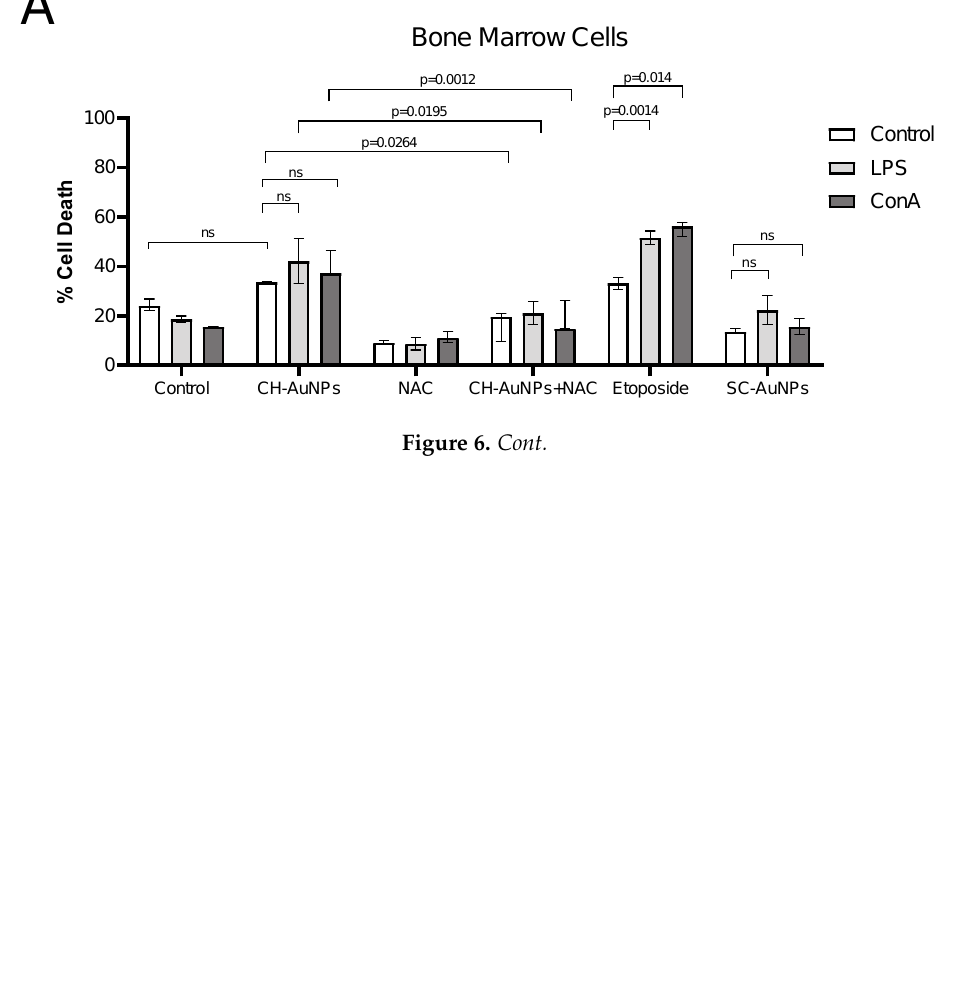
Figure 6. Cell-death analysis of CH-AuNPs, SC-AuNPs, and etoposide in BMCs, splenic mononuclear cells, and PBMCs under proliferative stimuli. Cell-death quantification of ( A ) BMC, ( B ) splenic mononuclear cells, and ( C ) PBMCs treated with CH-AuNPs (125 μM), SC-AuNPs (125 μM), and etoposide (100 mM) for 24 h, using lipopolysaccharide (LPS) and concanavalin A (ConA) for stimulation, and NAC as a ROS inhibitor. The results are presented as mean ± standard deviation of three different individuals. ns = not significant.